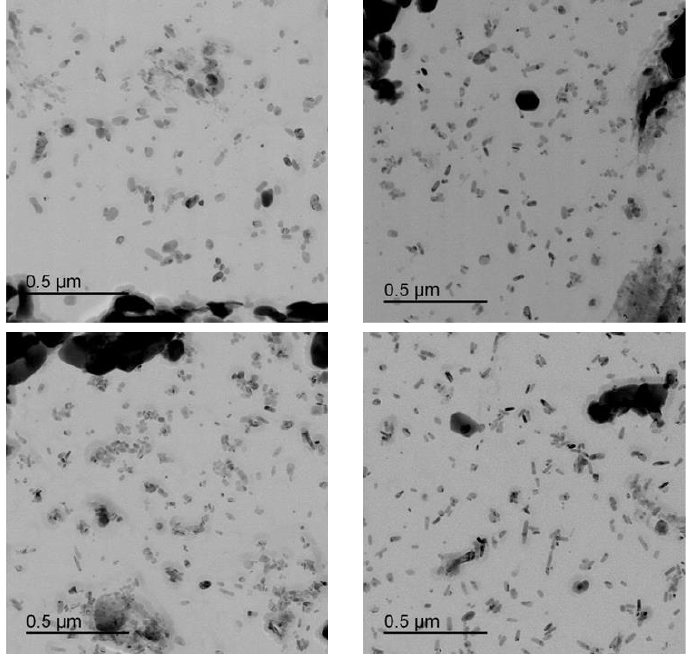
Figure 7. Failed crept cross-weld specimen 91-HAZ-3-1 550 °C 200 MPa 4395 h. TEM images on a carbon extraction replica at 100,000 X; MX, M 23 C 6 , and few Laves phases are present.